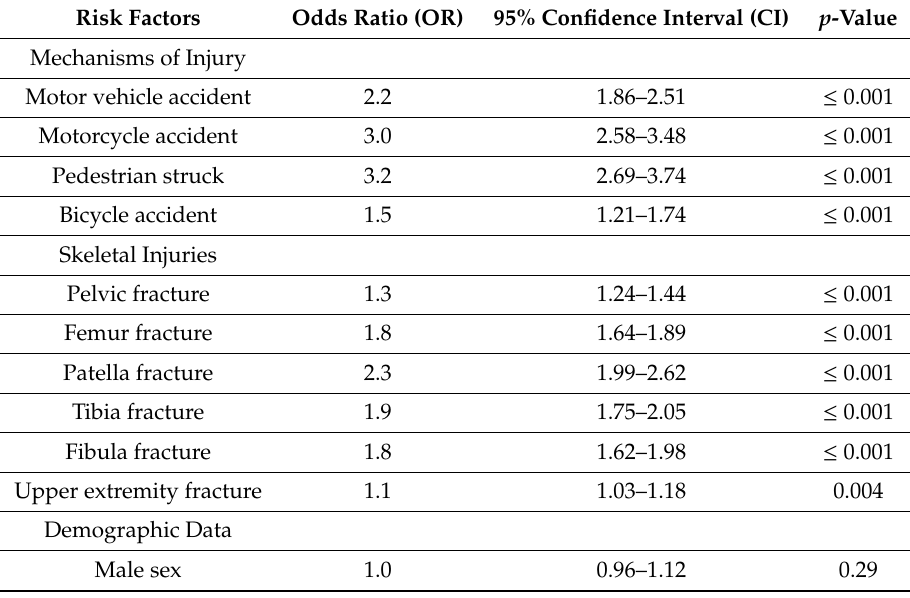
Table 4. Logistic regression analysis: predictors for ligamentous knee